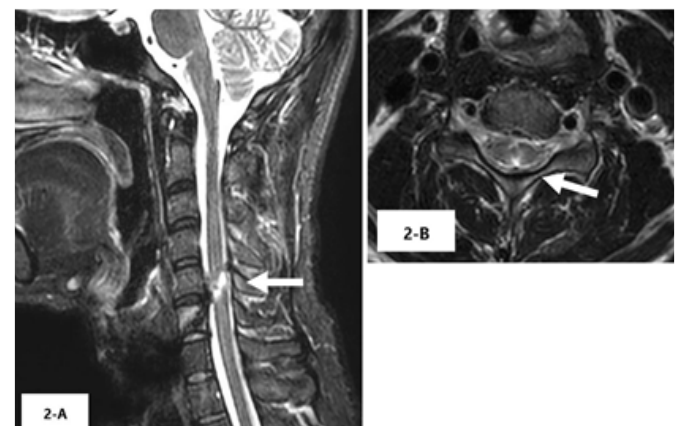
Image 2. Postsurgical cervical magnetic resonance